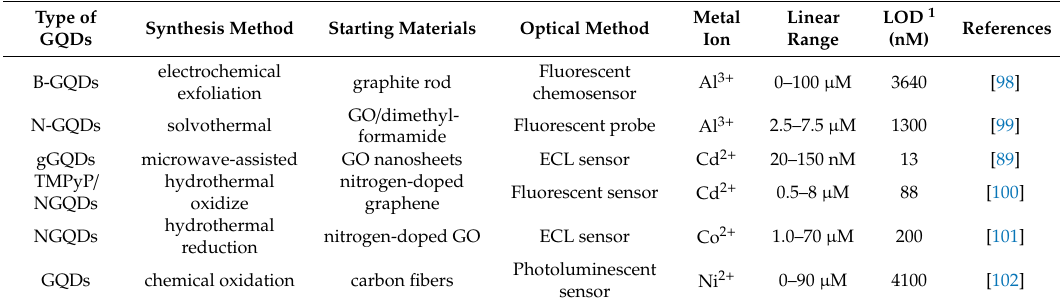
Table 7. The optical sensors based on GQDs for the detection of other toxic metal